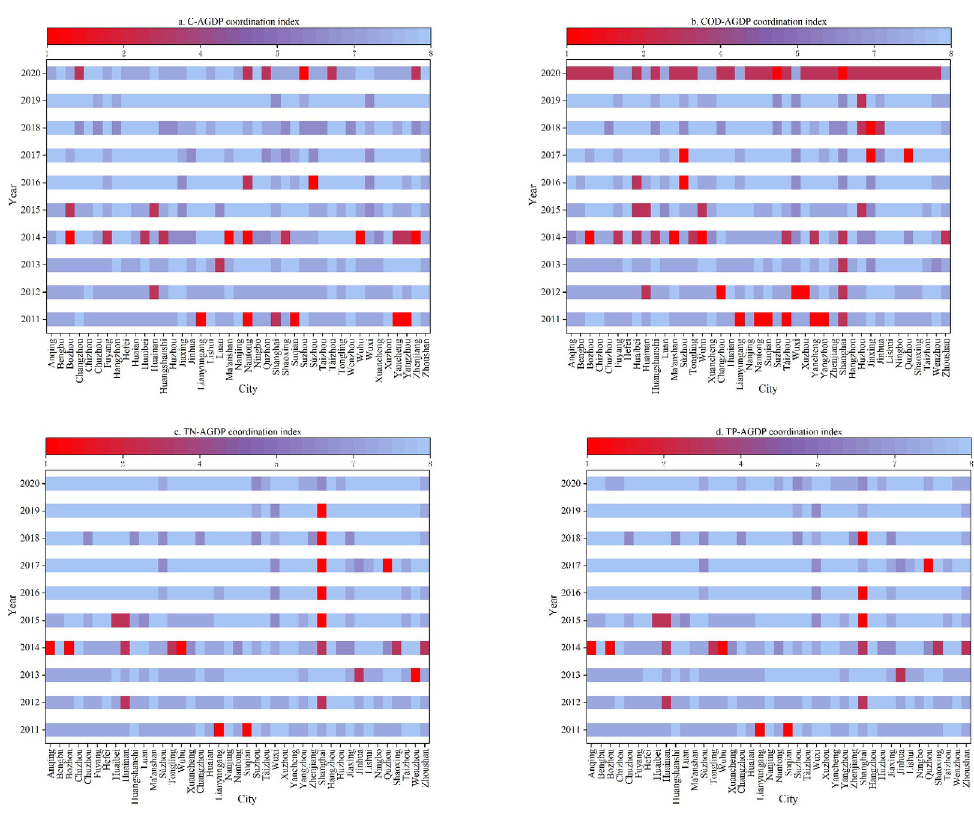
Fig 1. Decoupling agricultural pollution and carbon reduction from economic growth in the